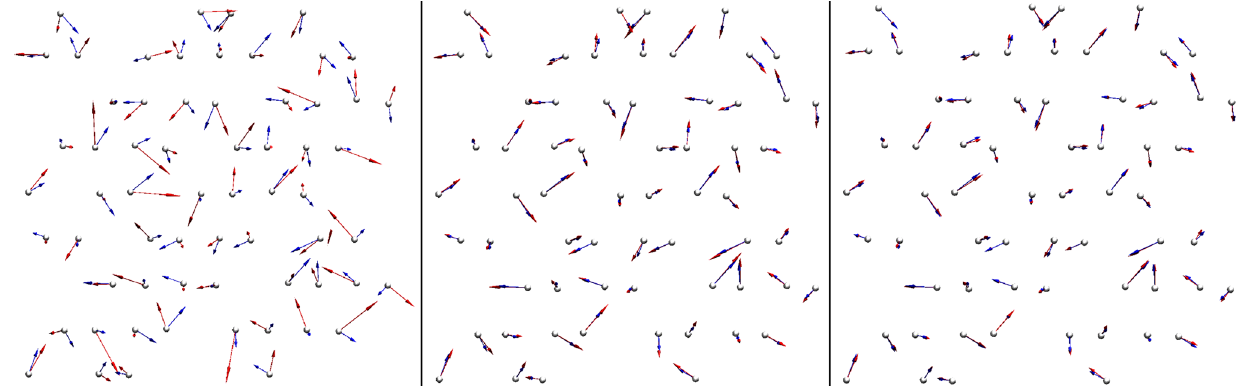
Fig. 2 Visual representation of different errors in forces. DFT forces ( blue vectors ) are shown on the atoms and are compared to EIP forces ( red vectors ) for 50%, 10% and 3% errors in forces from left to right